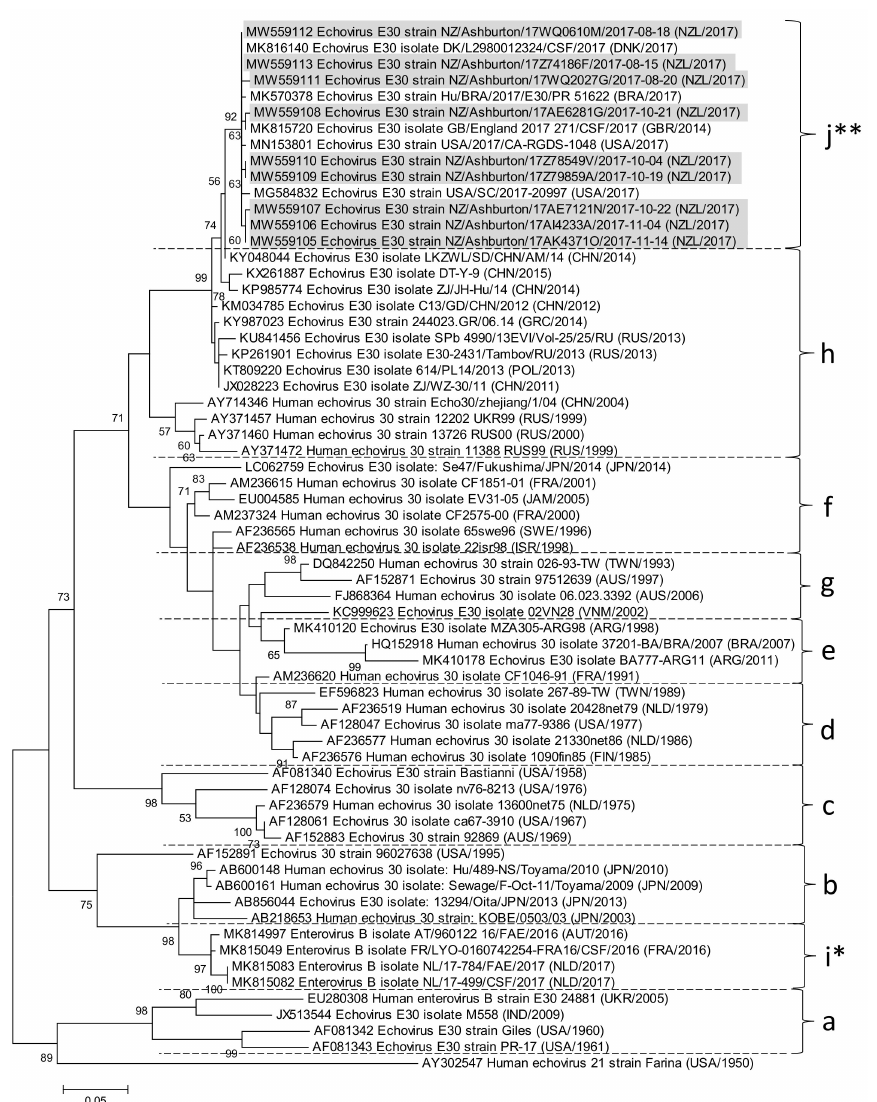
Figure 1. Maximum-likelihood phylogenetic tree (MEGA) after ClustalW alignment of partial VP1 sequences (331 nt), inferred by bootstrapping for 500 replicates. Genbank accession numbers for Ash- burton Echovirus E30 samples highlighted in grey: MW559105, MW559106, MW559107,